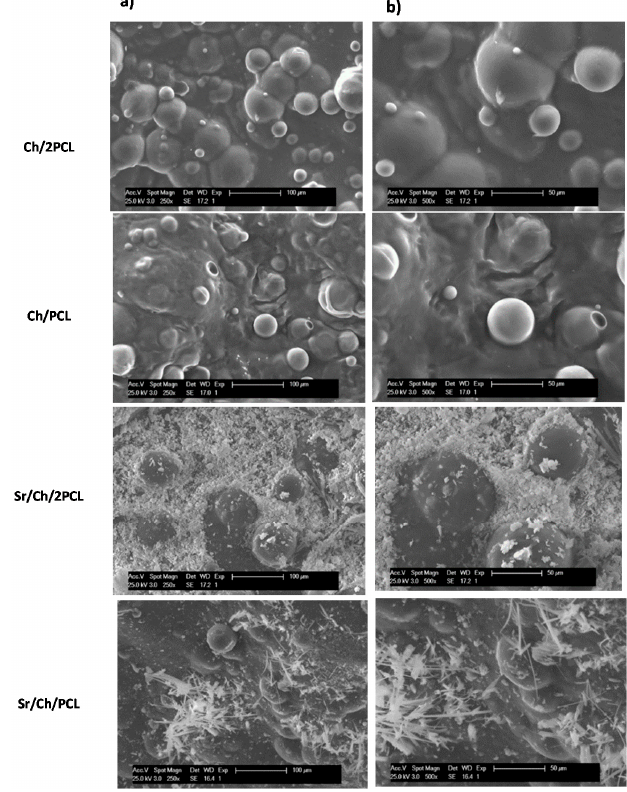
Figure 2. SEM images of dried blank and Sr(II) samples. ( a ) 250×; ( b ) 500×. Ch: chitosan; PCL: poly( ε - caprolactone).